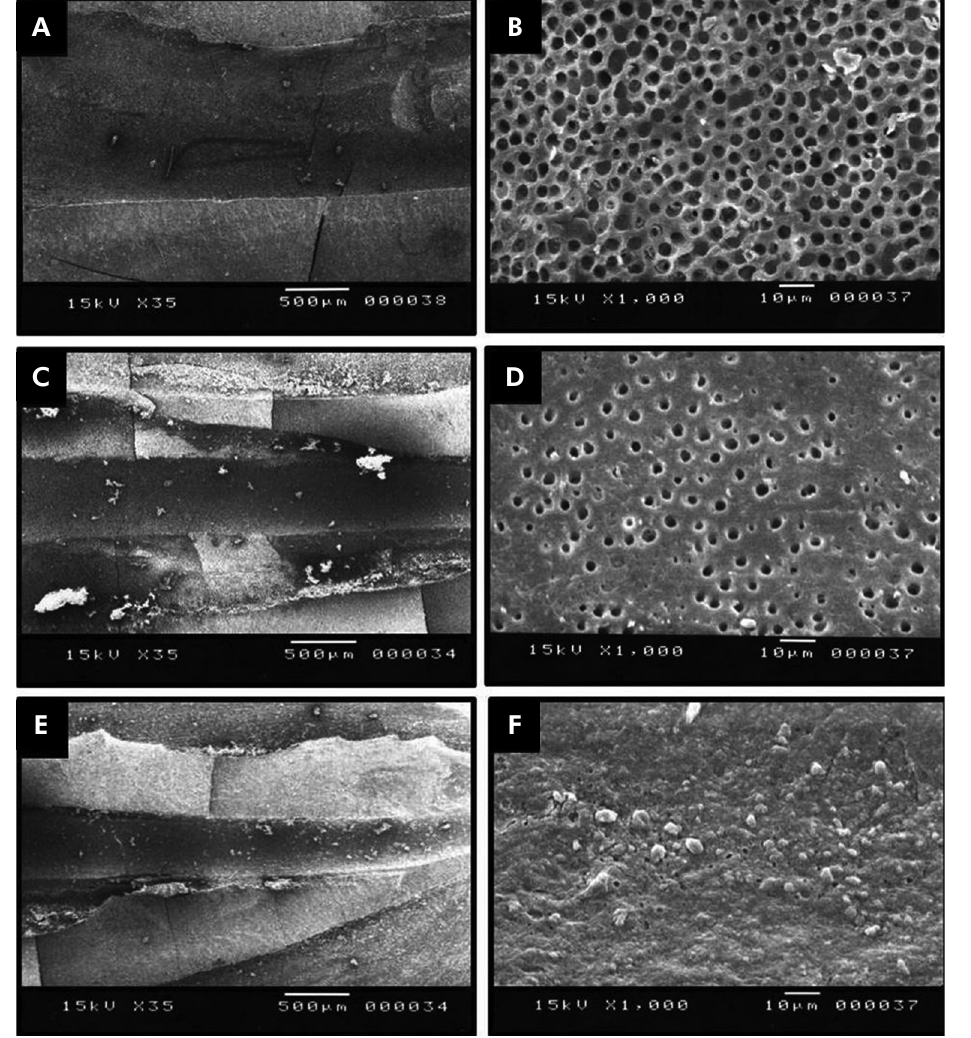
Figure 3. Representative SEM photomicrographs of the apical negative pressure irrigation protocol. A) Cervical third with debris (35×); B) Cervical third with open dentinal tubules (1,000×); C) Middle third with the debris scattered on the surface (35×); D) Middle third with visible dentinal tubules (1,000×); E) Apical third with > 50% of the surface covered with debris (35×); F) Apical third with a few visible dentinal tubules and smear layer partially covering the surface